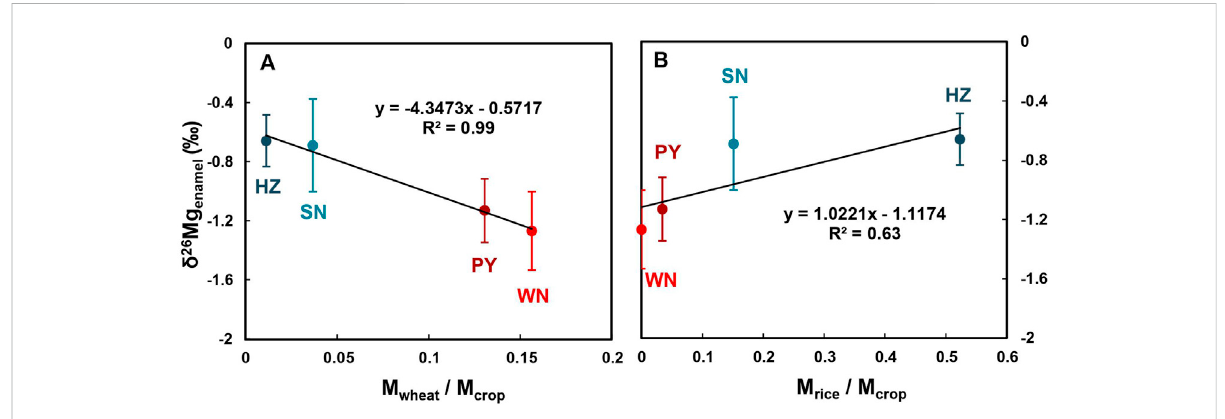
FIGURE 6 The M wheat /M crop (A) and M rice /M crop (B) in different regions and the δ 26 Mg enamel in local people (mean with 2SD, refer to Table 2 for detailed calculation method). Error bars indicate the 2SD of the mean